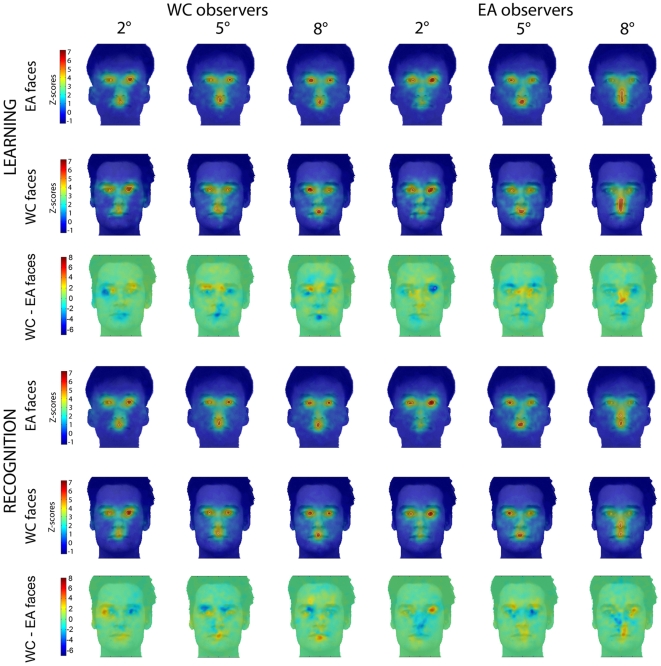
Caucasian (WC) and East Asian (EA) group fixation maps for learning and recognition trials.Face areas fixated with above chance frequency are delimited by white borders. As revealed by the lack of significant differences in the differential fixation maps (3rd and 6th row), fixation strategies of both cultural groups were consistent as a function of the race of the faces within their respective Spotlight conditions.